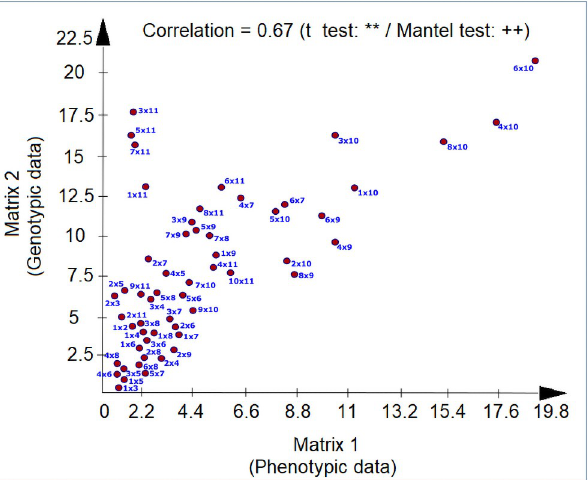
Fig 1. Graphic dispersion of pairs of sugarcane genotypes determined based on dissimilarity measurements obtained from phenotypic (x axis) and genotypic (y axis) data. The correlation between the matrices is illustrated. �� p = 0.01, as determined using a t test; ++ p = 0.01, as determined using the Mantel test based on 1,000 simulations.